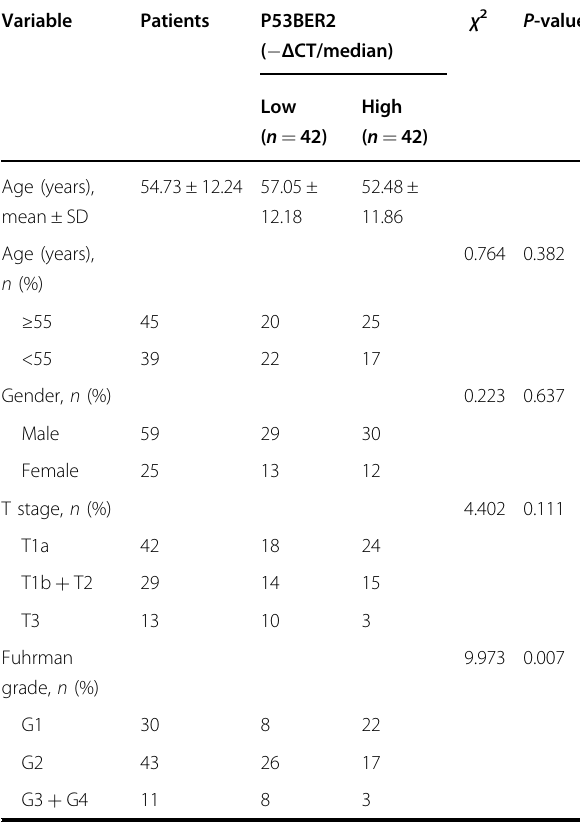
Table 1 Association between p53BER2 expression level and clinical features of RCC